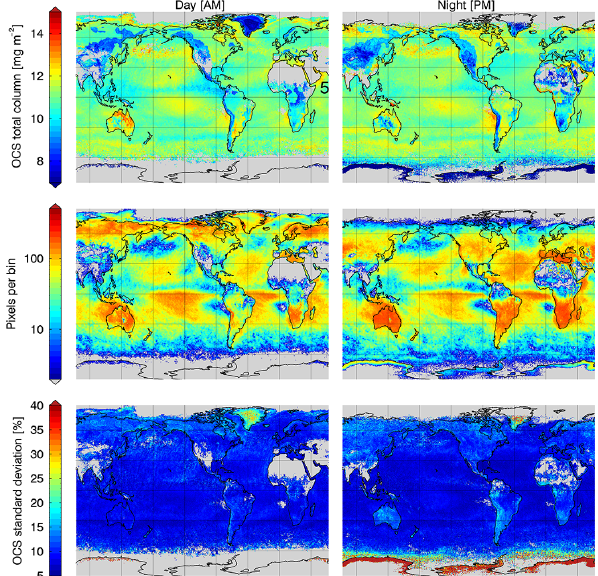
Figure 13. Same as in Fig. 10, but for July–August 2014. Figure 14. Same as in Fig. 10, but for September–October